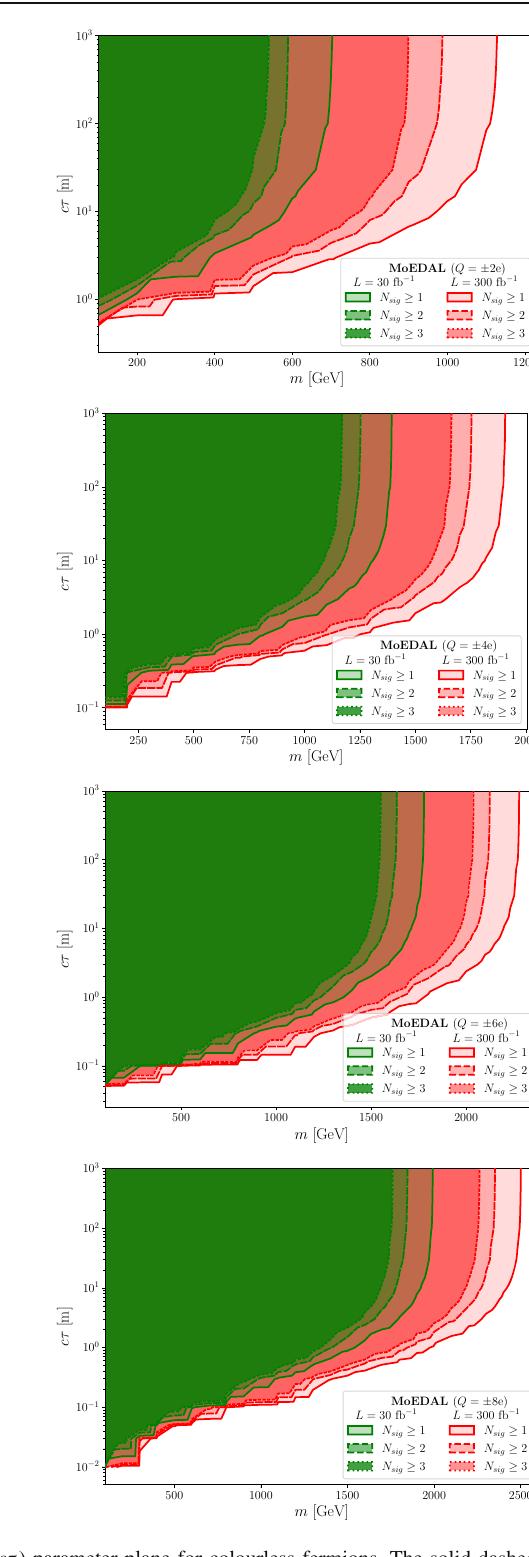
Fig. 16 Model-independent detection reach at MoEDAL in the ( m , c τ ) parameter plane for colourless fermions. The solid dashed and dotted contours correspond to N sig = 1, 2 and 3, respectively. Green and red contours correspond to Run-3 ( L = 30 fb − 1 ) and HL-LHC ( L = 300 fb − 1 ) luminosities